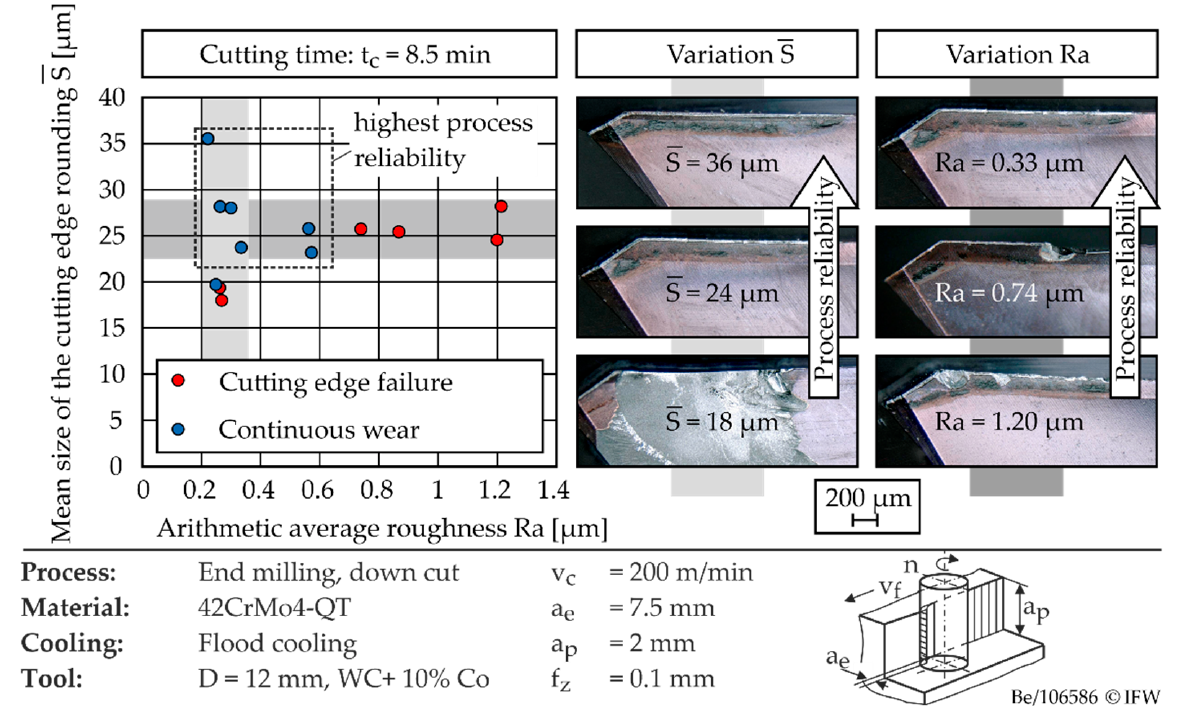
Figure 8. Wear behavior of coated cutting tools as a function of the mean size of the cutting edge rounding and the arithmetic average roughness value.